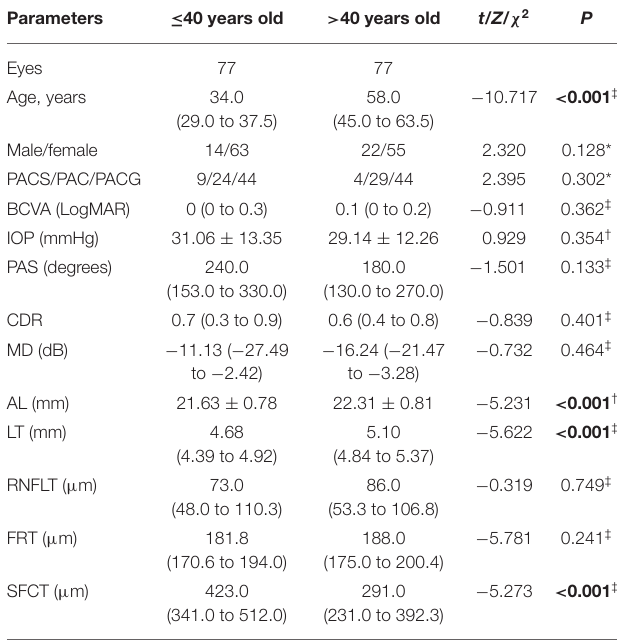
TABLE 1 | Basic clinical data of PACD of different age groups.